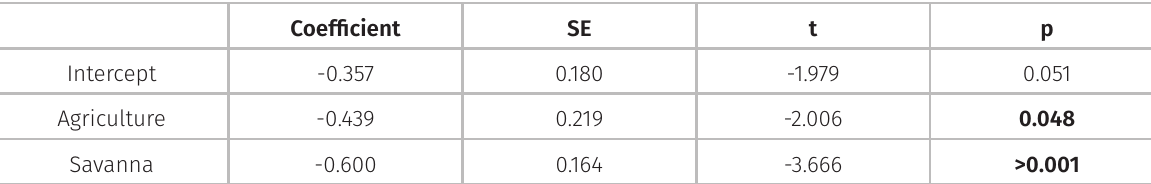
Table III. Statistical results (coefficient estimates, standard error [SE], t value, and p-value) for the best